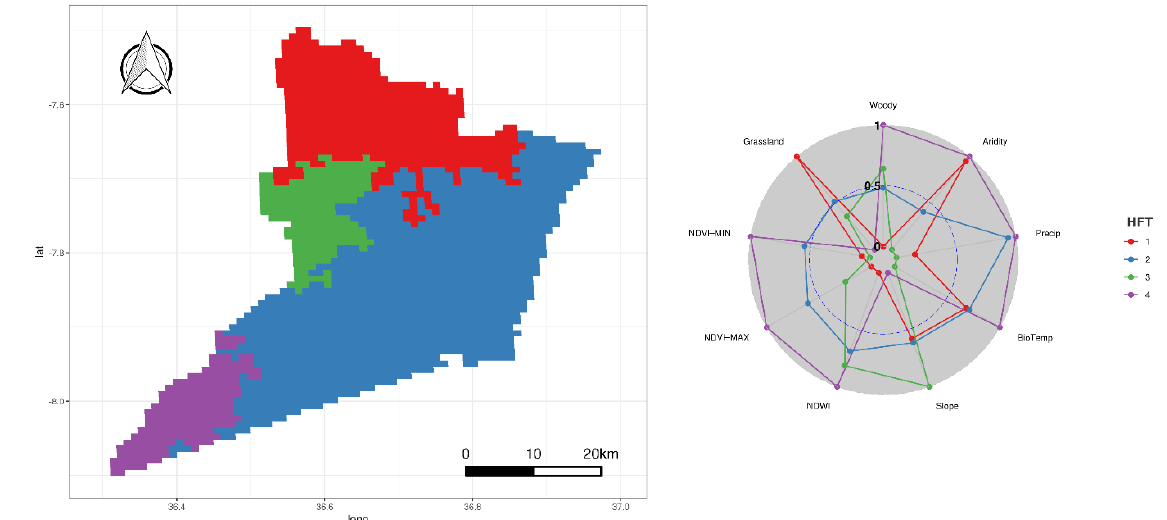
Figure 2. Example map of the habitat functional types (HFTs) identified in Udzungwa Mountains National Park (Tanzania) and normalized mean values of the biophysical variables used in the eHabitat+ model (EPSG:4326). NDVI stands for the normalized difference vegetation index, and NDWI stands for the normalized difference water index. A detailed description of the study variables and the methodology followed can be found in [120].